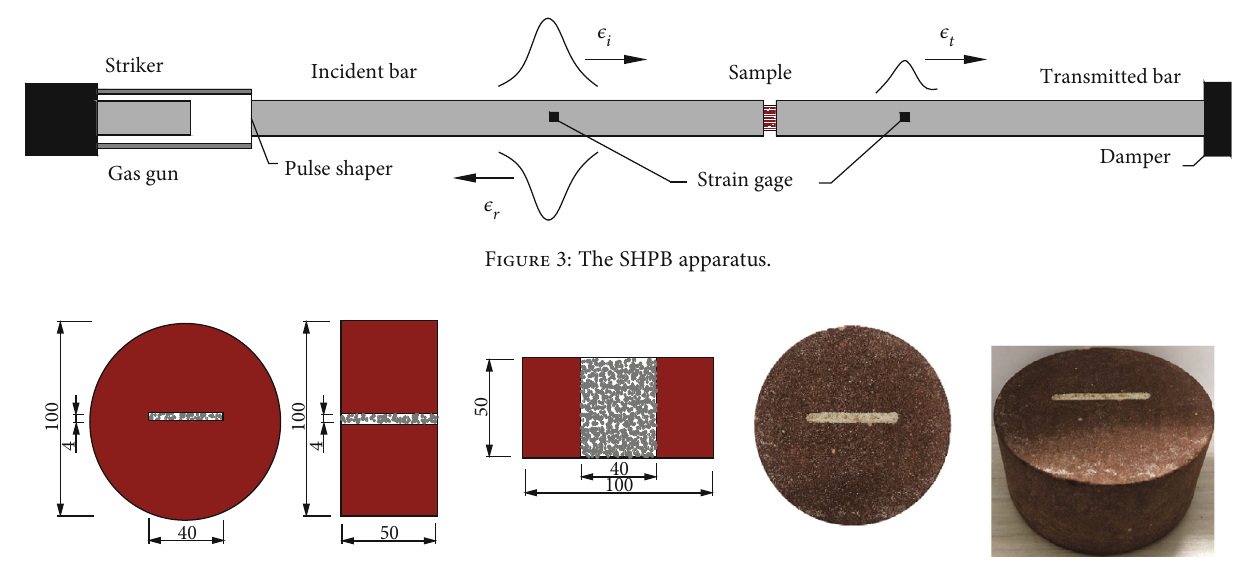
Figure 4: Schematics of the